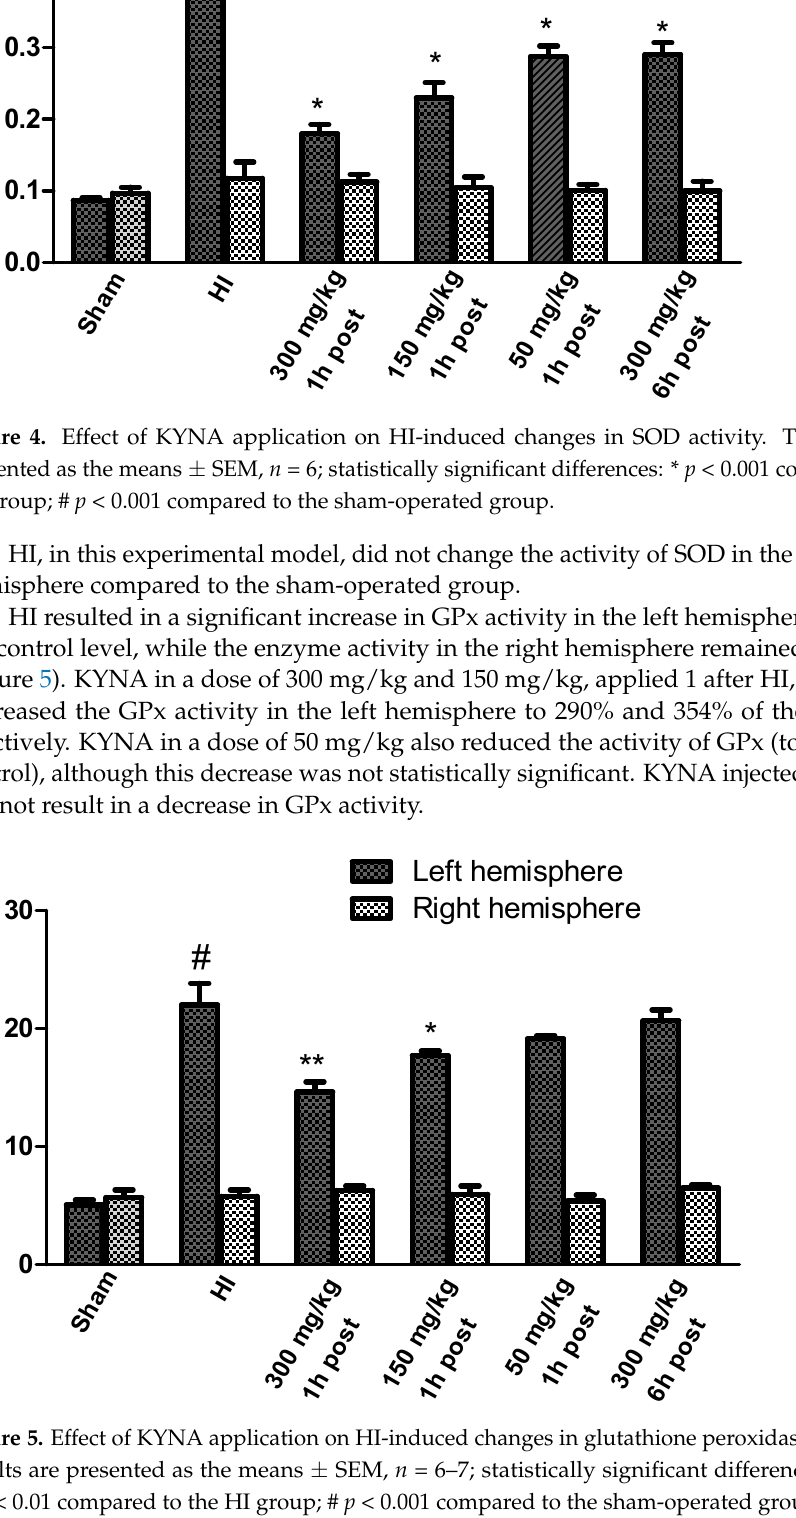
The GSH concentration determined in brains isolated from control rats ranged be- tween 29.7 and 30.25 nmol/mg of protein in the left and right hemispheres, respectively (Figure 6). 010 20 30 40